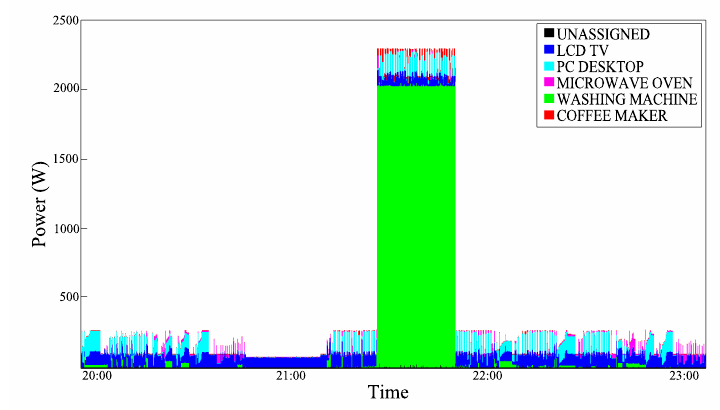
Figure 12. Power consumption disaggregation obtained with Kolter and Jaakkola [9]’s AFAMAP algorithm—test case 2.